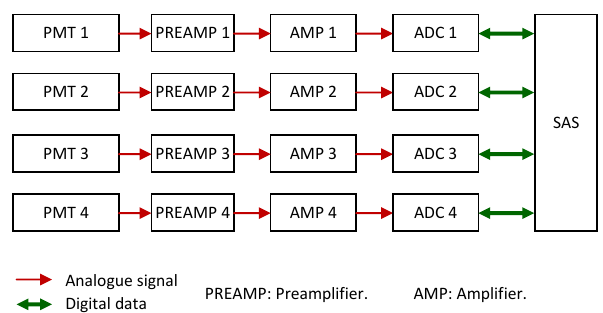
Figure 18. NIM modules and SAS interconnection block diagram working in software coincidence with four detection chains. The signal from each PMT is amplified by a preamplifier and an am- plifier in order to get the appropriate ADC input level. SAS detects coincidence and registers